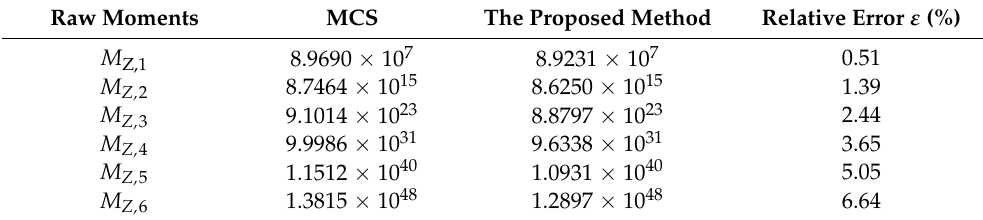
Table 3. The results of the raw moments.